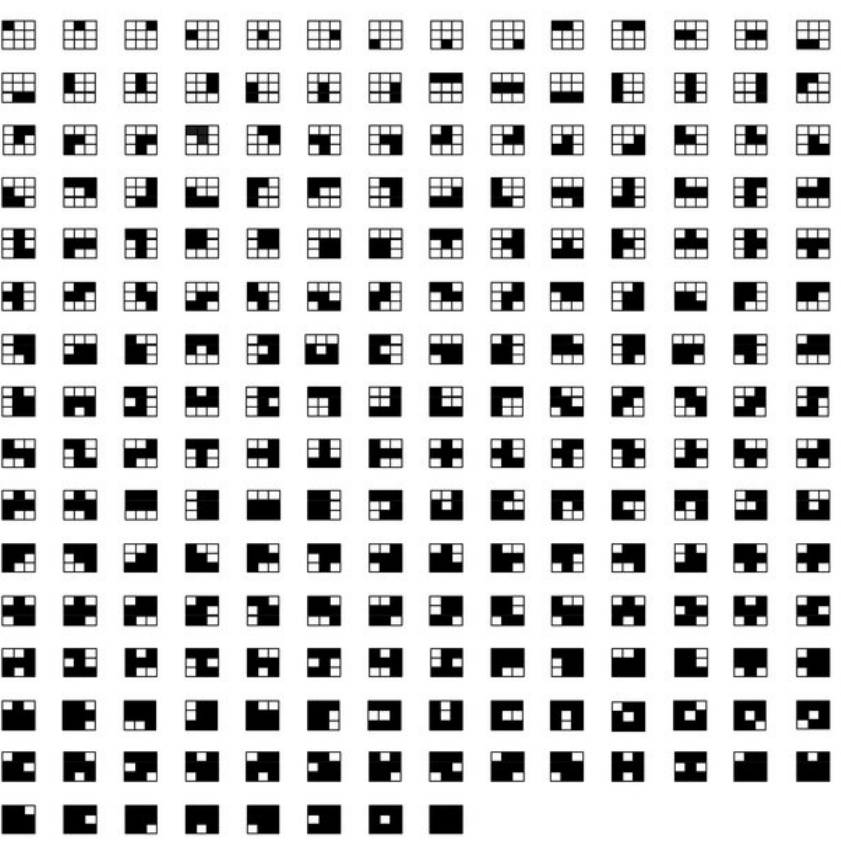
Figure 4: The available set of direction relation matrix symbols for two simple regions